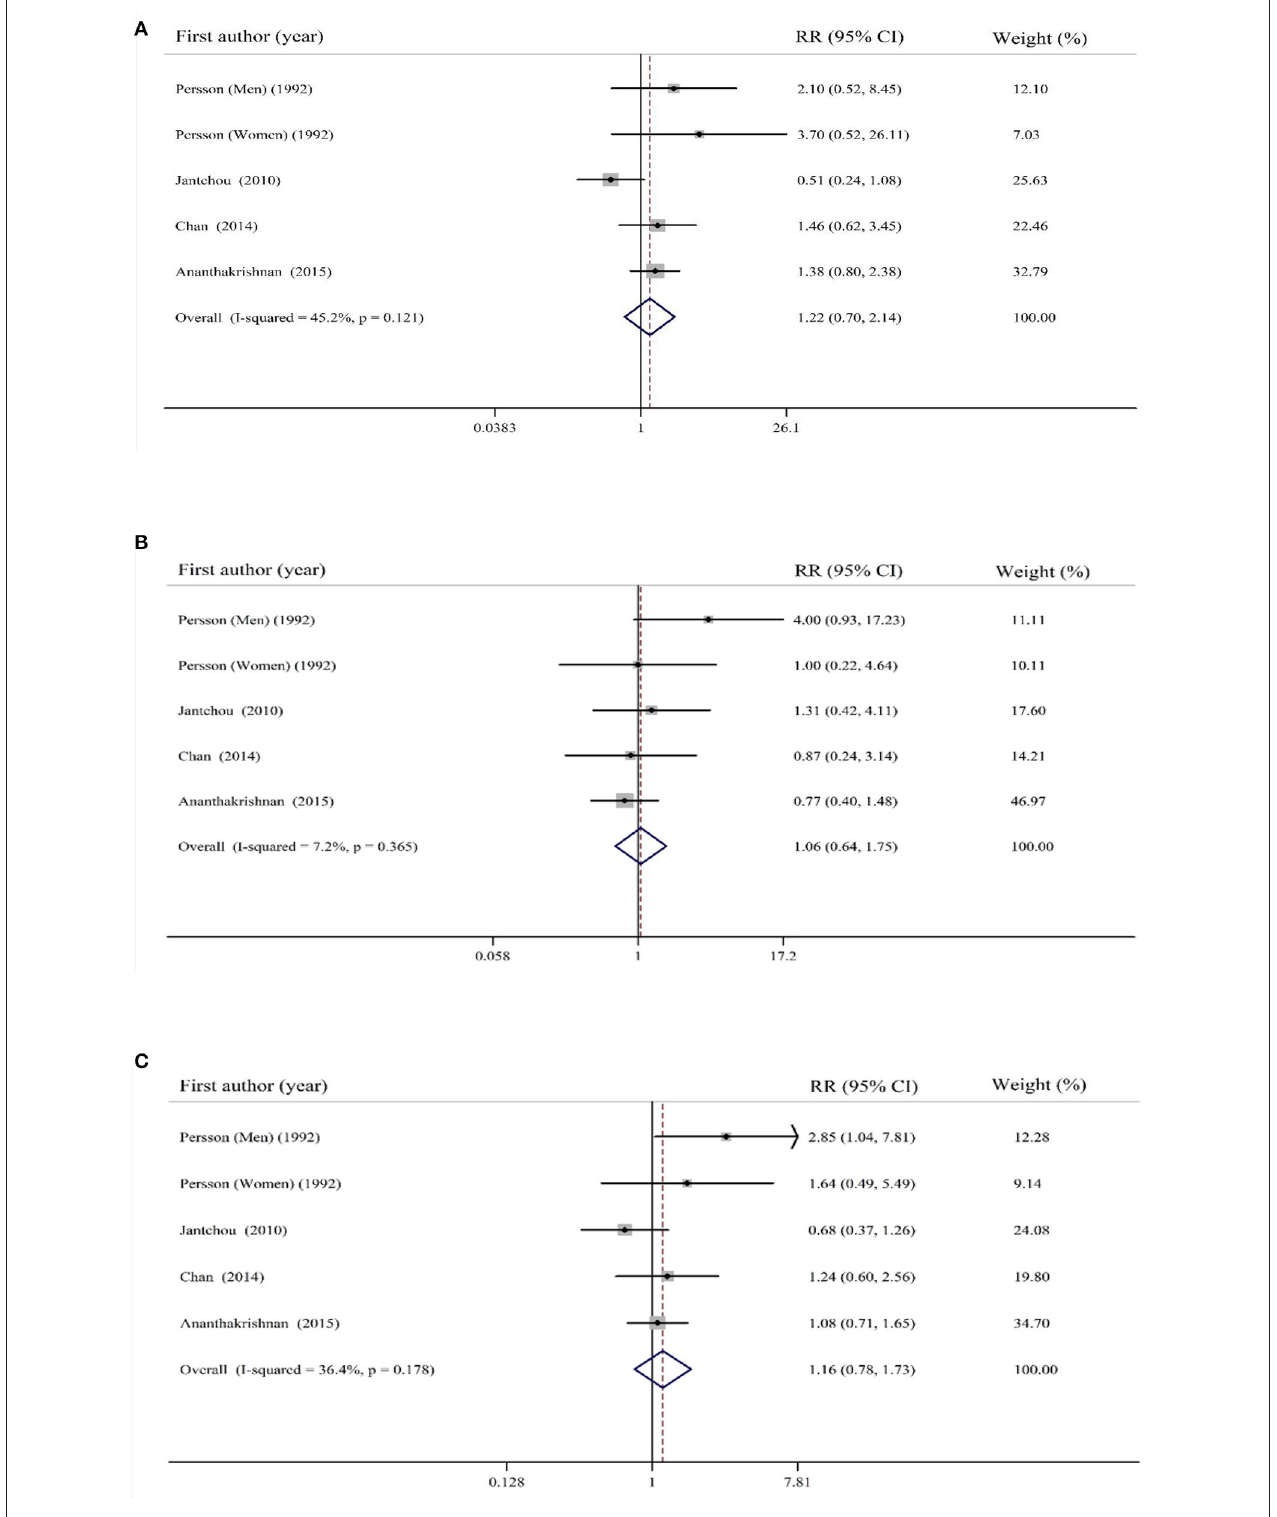
FIGURE 2 | Forest plot for the association of total carbohydrates intake with risk of (A) ulcerative colitis (UC), (B) Crohn’s disease (CD), and (C) total inflammatory bowel disease (IBD). Diamonds represent pooled estimates from random-effects analysis. Horizontal lines represent 95% CIs.